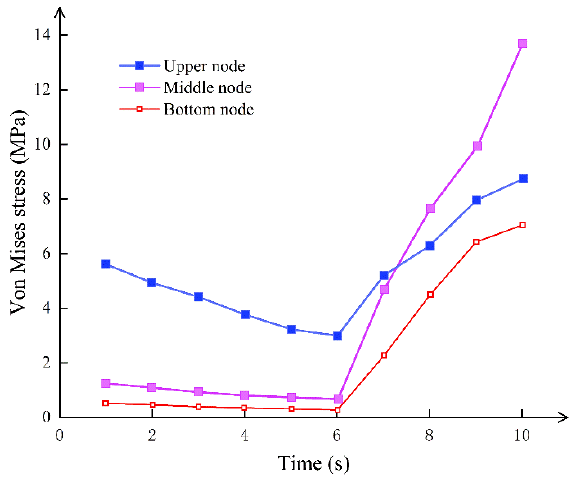
Figure 8. Stress–time curve of the upper, middle, and lower joints on the interface between the bolt and hand